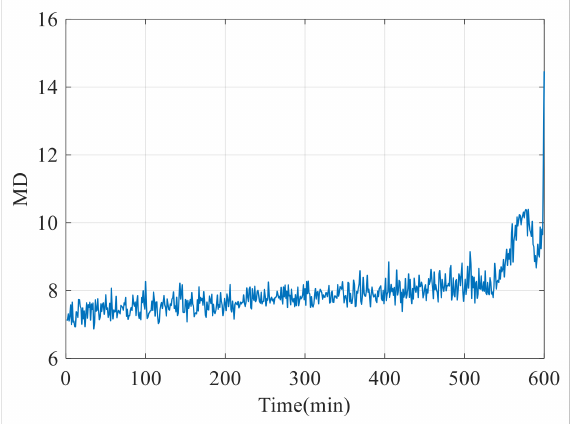
Figure 12. HI constructed by MD.